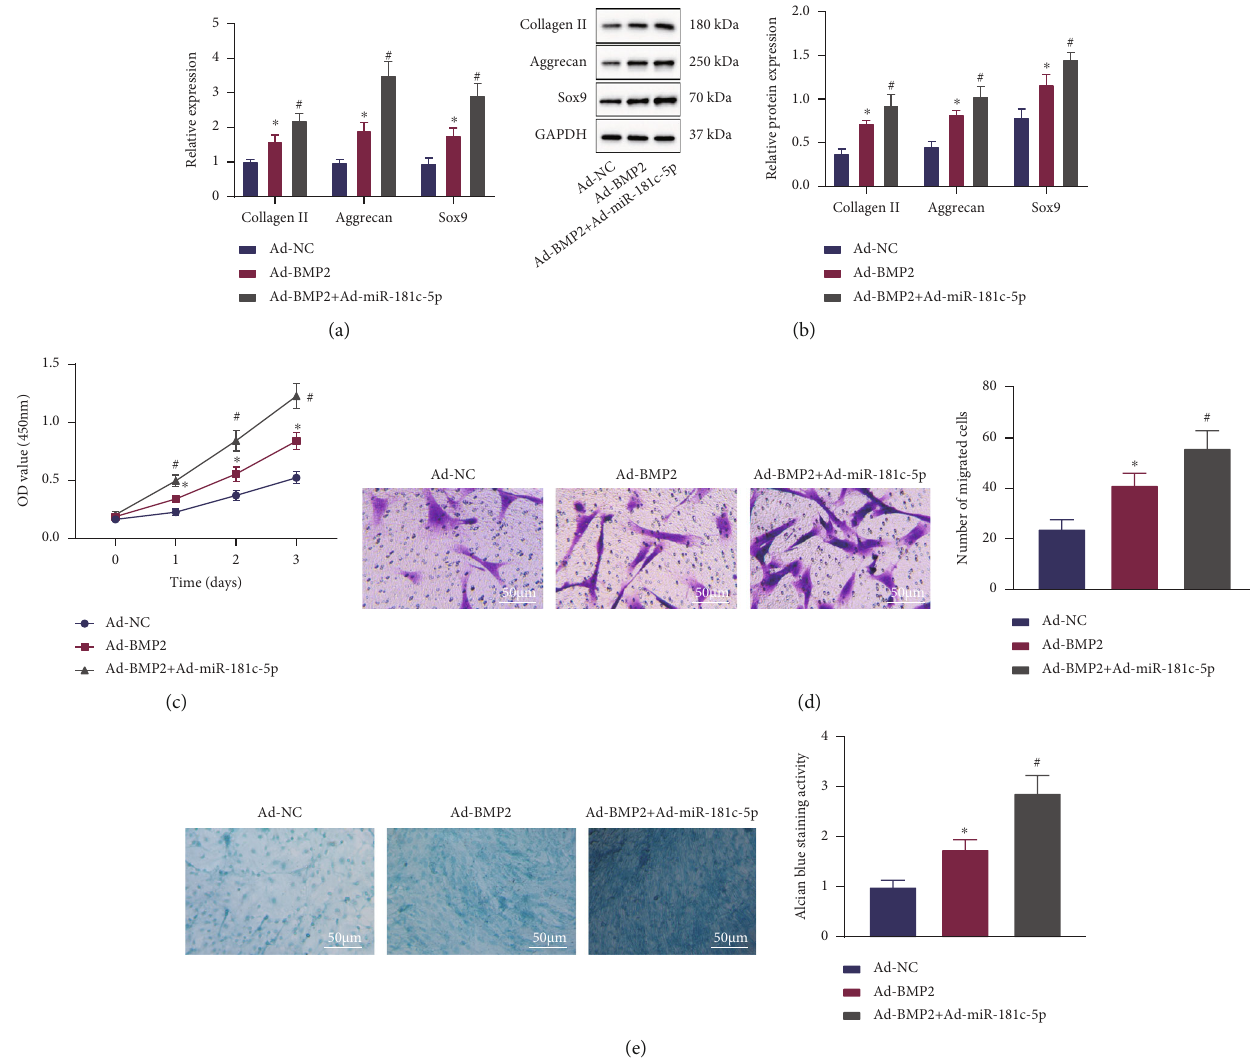
Figure 6: E ff ect of the BMP2/miR-181c-5p/SMAD7 axis on the proliferation, migration, and cartilage di ff erentiation of BMSCs. BMSCs were treated with Ad-BMP2 alone or combined with Ad-miR-181c-5p. (a) mRNA levels of collagen II, aggrecan, and Sox9 in BMSCs determined by RT-qPCR. (b) Protein levels of collagen II, aggrecan, and Sox9 in BMSCs measured by Western blot analysis. (c) Proliferation of BMSCs detected by the CCK8 assay. (d) Migration of BMSCs detected by the Transwell assay ( scalebar = 50 μ m ). (e) Cartilage di ff erentiation ability of BMSCs detected by Alcian blue staining ( scalebar = 50 μ m ). ∗ p < 0 : 05 , compared with BMSCs treated with Ad-NC; # p < 0 : 05 , compared with BMSCs treated with Ad-BMP2. All experiments were repeated for three